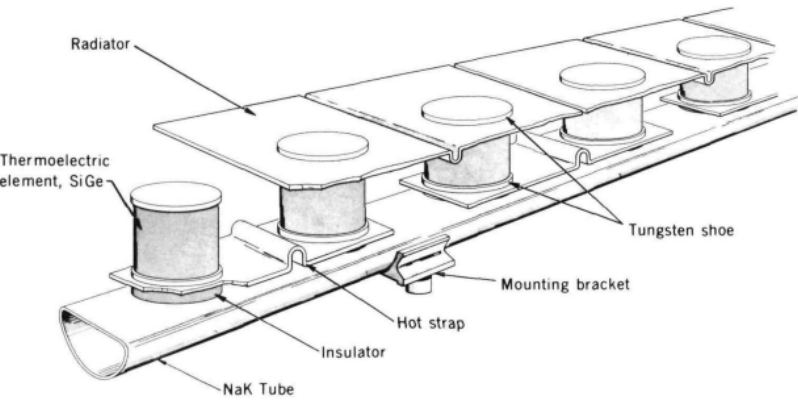
Figure 1. Schematic of first-generation Si-Ge couples used in the 1965 SNAP-10A